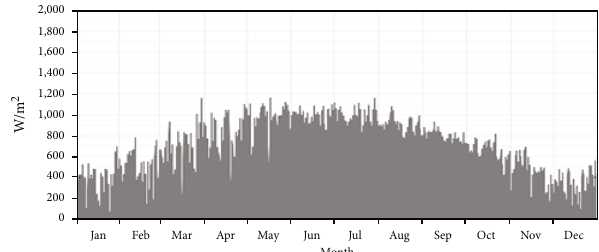
Figure 5: Annual solar radiation intensity in Tehran [http://www .tehranmet.ir/].